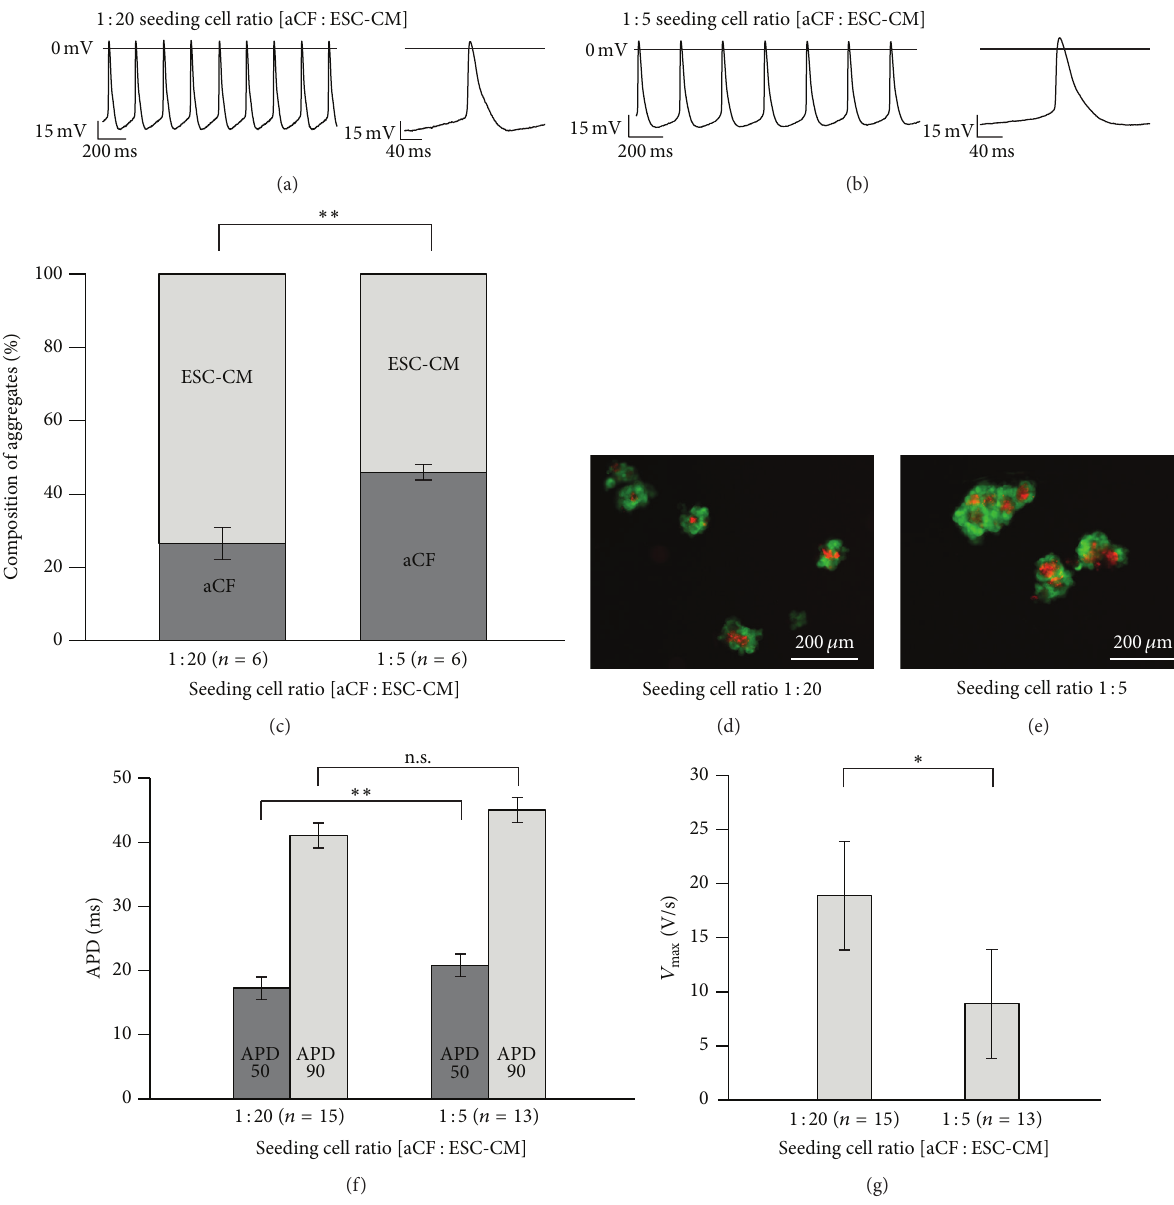
Figure4:ImpactofdifferentseedingaCFdensitiesonactionpotentialrecordingsofcocultureswithESC-CMs. RepresentativeAPwaveforms of cocultures with a lower (1: 20) (a) and higher (1:5) (b) seeding number of aCFs. Percentage of ESC-CMs and aCFs in hanging drops cocultured for two days (c). Pictures of cocultures with aCF seeding ratios 1 :20 (d) and 1: 5 (e) after two days in culture. Higher number of aCFs in cocultures resulted in a decreased maximal upstroke velocity ( 𝑉 max ) (f) as well as a prolonged APD50 (g). Data are expressed as mean ± SEM; ∗ 𝑝 < 0.05 ; ∗∗ 𝑝 < 0.01 .